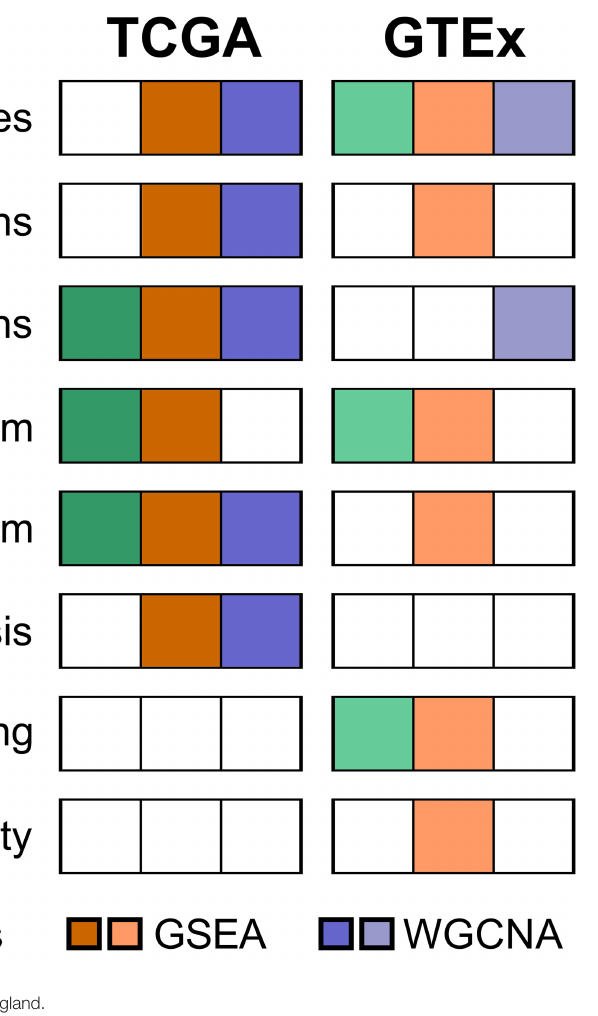
FIGURE 8 | A summary chart showing pathways associated with aging in the thyroid